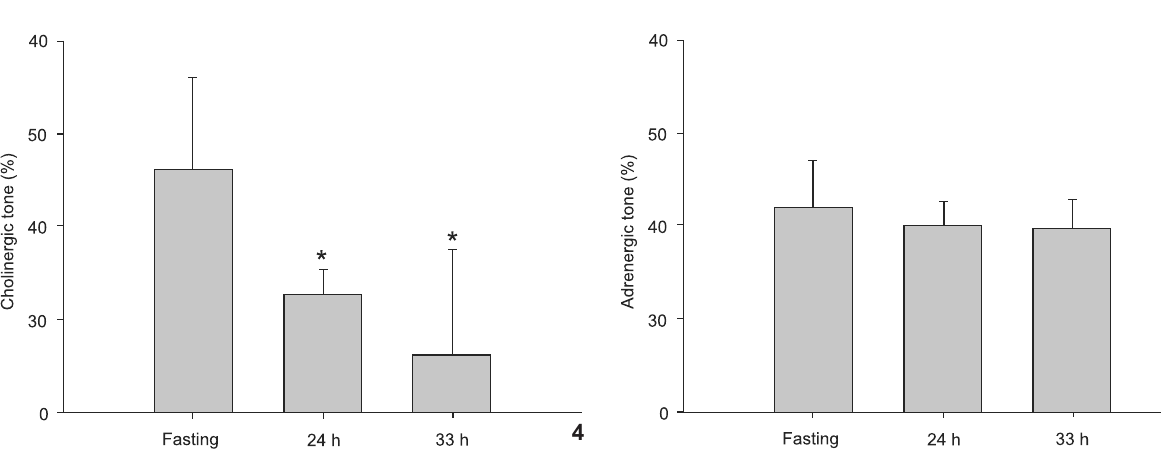
Figures 4-5. Cholinergic (4) and adrenergic (5) tones on the heart in fasting and digesting Lithobates catesbeianus . The significant reduction in cholinergic tone during digestion is marked by asterisks, whereas the adrenergic tone was unaffected by digestion. Values are presented as mean ± SEM; (N =